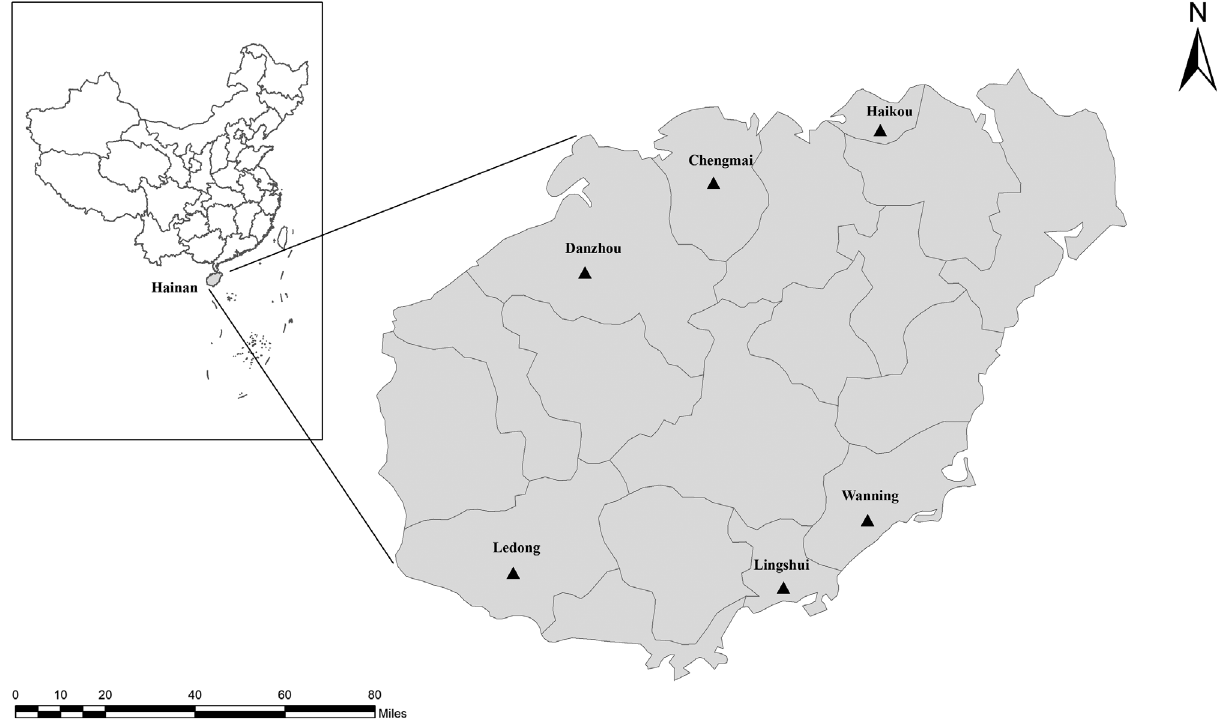
Figure 1. Speci fi c locations where samples were collected in this study. N : Sampling points.